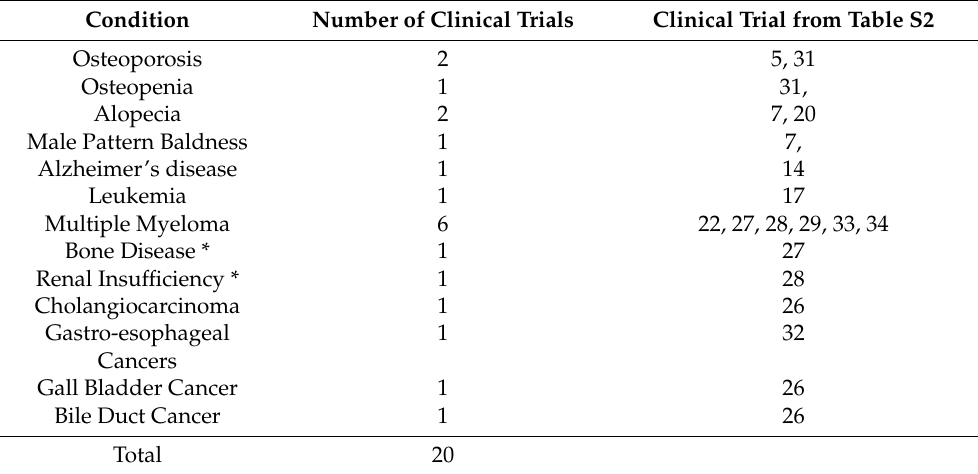
Table 6. Clinical trials involving enhancers of Wnt